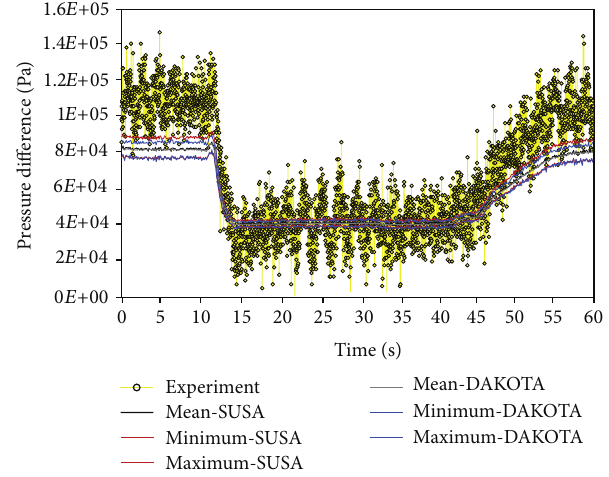
Figure 3: Pressure difference as a function of time for the turbine trip.